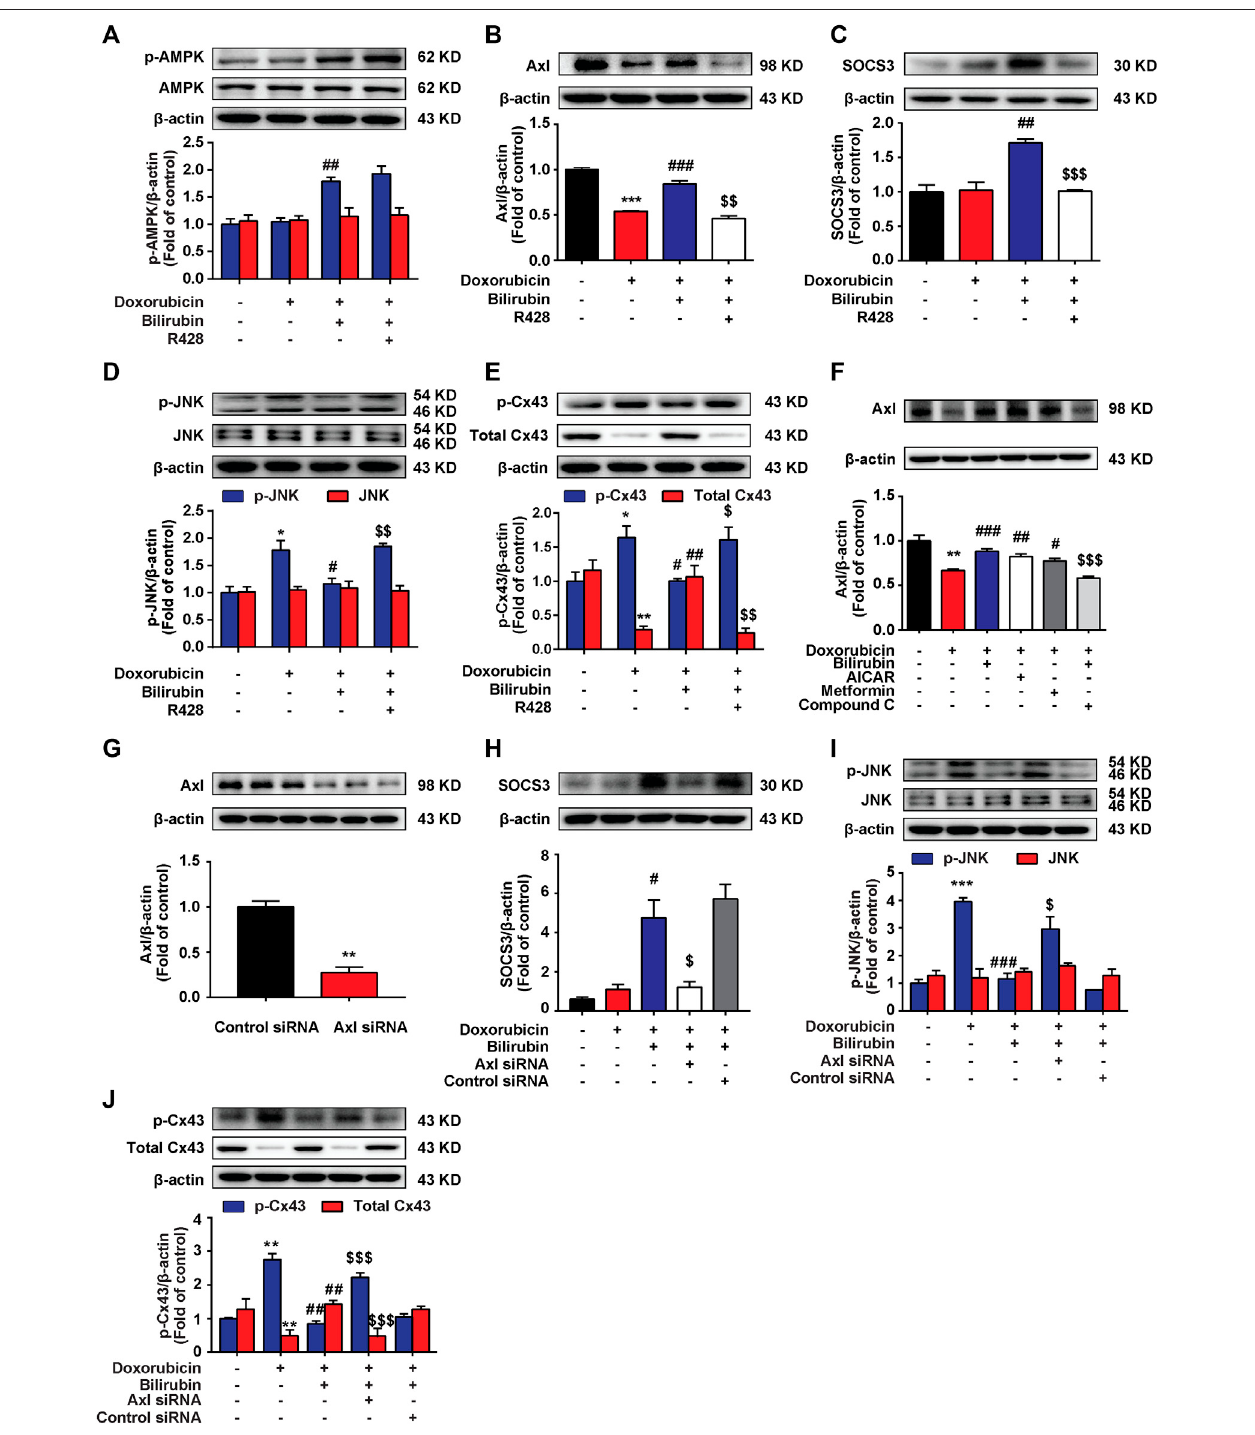
FIGURE 6 | Bilirubin induces SOCS3 expression via activating Axl receptor in H9C2 cells. (A – E) Representative western blot bands showed the levels of p-AMPK, AMPK, Axl, SOCS3, p-JNK, JNK, p-Cx43, and total Cx43 in H9C2 cells in vitro . H9C2 cells were pretreated with R428 (1 μ M) for half an hour before bilirubin treatment, and then cells were cultured with bilirubin (0.1 μ M) for 6 h, followed by doxorubicin treatment (1 μ M) for another 24 h. The western blot samples were collected and analyzed( n =4ofeachgroup). (F) RepresentativewesternblotbandsshowedthelevelsofAxlinH9C2cells. (G) Theef fi ciencyofAxlknockdownwasassessedby western blot assay. (H – J) Representative western blot bands showed the levels of SOCS3, p-JNK, JNK, p-Cx43, and total Cx43 in H9C2 cells. H9C2 cells were transfected with 100 pM Axl siRNA or control siRNA for 24 h, and then subjected to bilirubin (0.1 μ M) for 6 h, followed by exposure to doxorubicin (1 μ M) for another 24 h. The western blot samples were collected and analyzed ( n ≥ 3 each group). Signi fi cant difference was revealed following one-way ANOVA (* p < 0.05, ** p < 0.01, *** p < 0.001 vs. Control group; # p < 0.05, ## p < 0.01, ### p < 0.001 vs. Doxorubicin-treated group; $ p < 0.05, $$ p < 0.01, $$$ p < 0.001 vs. Doxorubicin and bilirubin- treated group; Bonferroni post hoc